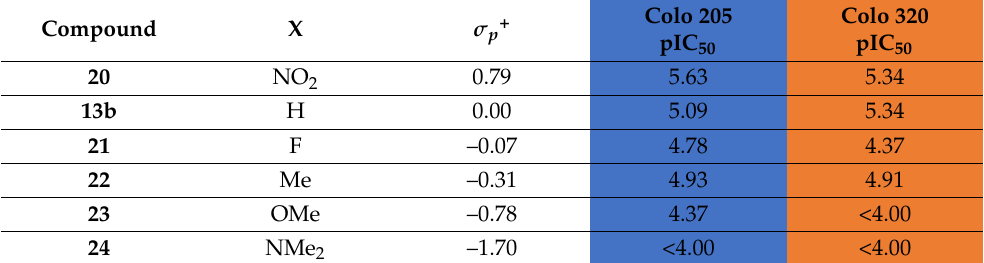
Table 4. The Hammett–Brown constant ( σ p + ) for substituents (X) at the para position and the corre- sponding negative logarithm of IC 50 (pIC 50 ).